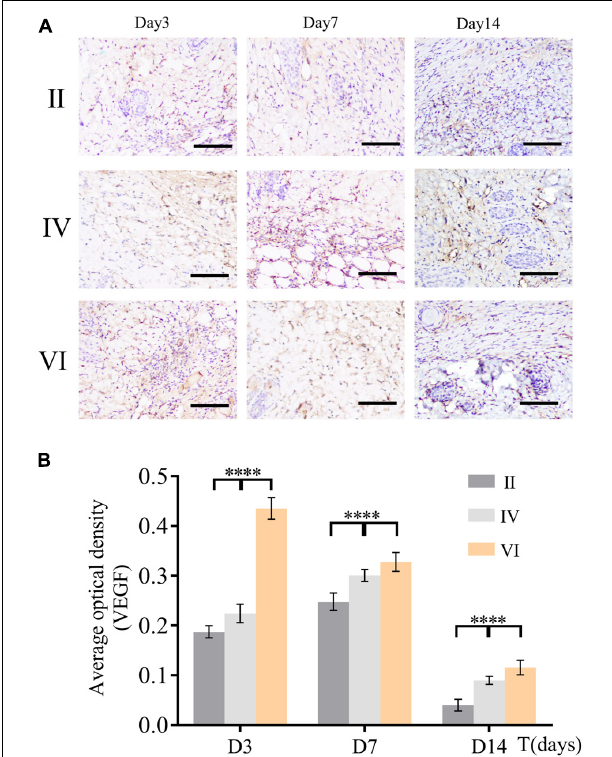
FIGURE 10 | (A) Immunofluorescence staining for CD31 of the wound tissues during the healing on days 3, 7, and 14, respectively. Scale bar, 200 µ m. (B) Vascular density was calculated by ImageJ. ( n = 6, data = mean ± SD.) (II: NIR; IV: HA hydrogel + NIR; and VI: CuS/HA hydrogel +